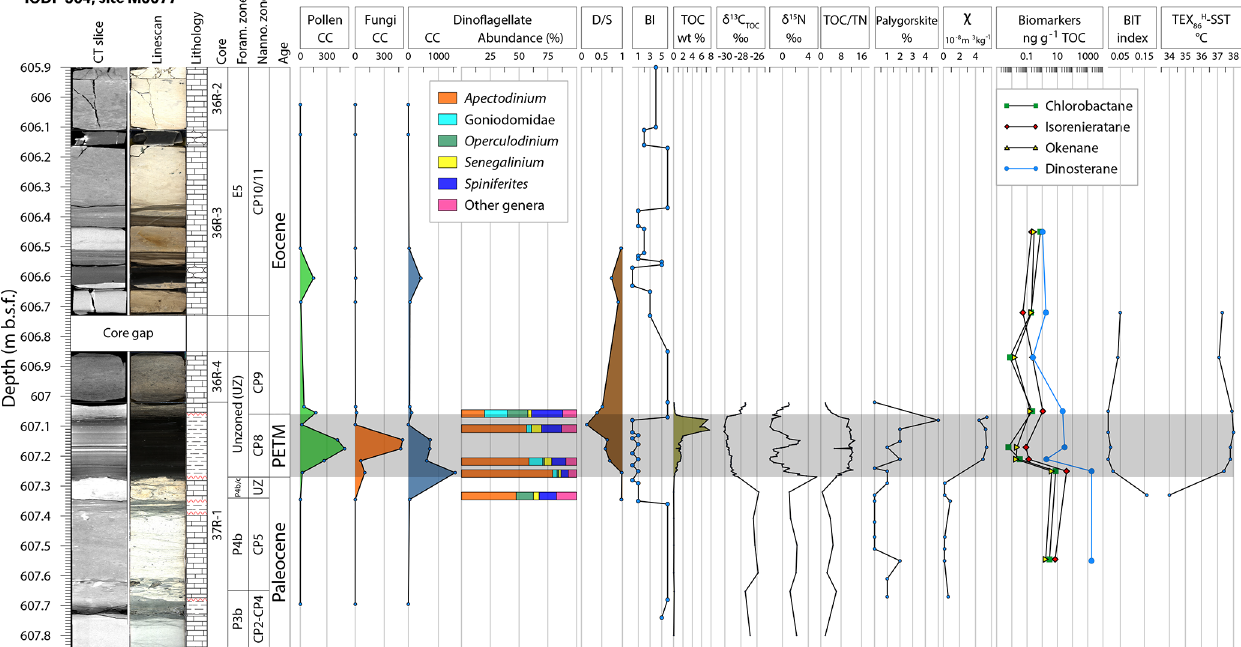
Figure 2. Stratigraphic column of Site M0077. Palynological concentrations (CC) are given as specimens per gram. δ 15 N is reported relative to atmospheric N 2 , and δ 13 C TOC is reported relative to VPDB. BI: bioturbation index (Taylor and Goldring, 1993), CT: computed tomography, D / S: dinoflagellate cyst to pollen and plant spore ratio (Warny et al., 2003), TOC / TN: total organic carbon / total nitrogen, TOC: total organic carbon, χ : magnetic susceptibility. Lithological symbols: rectangular blocks – limestone, dashes – shale and claystone, obround ovals – chert, red wavy lines –